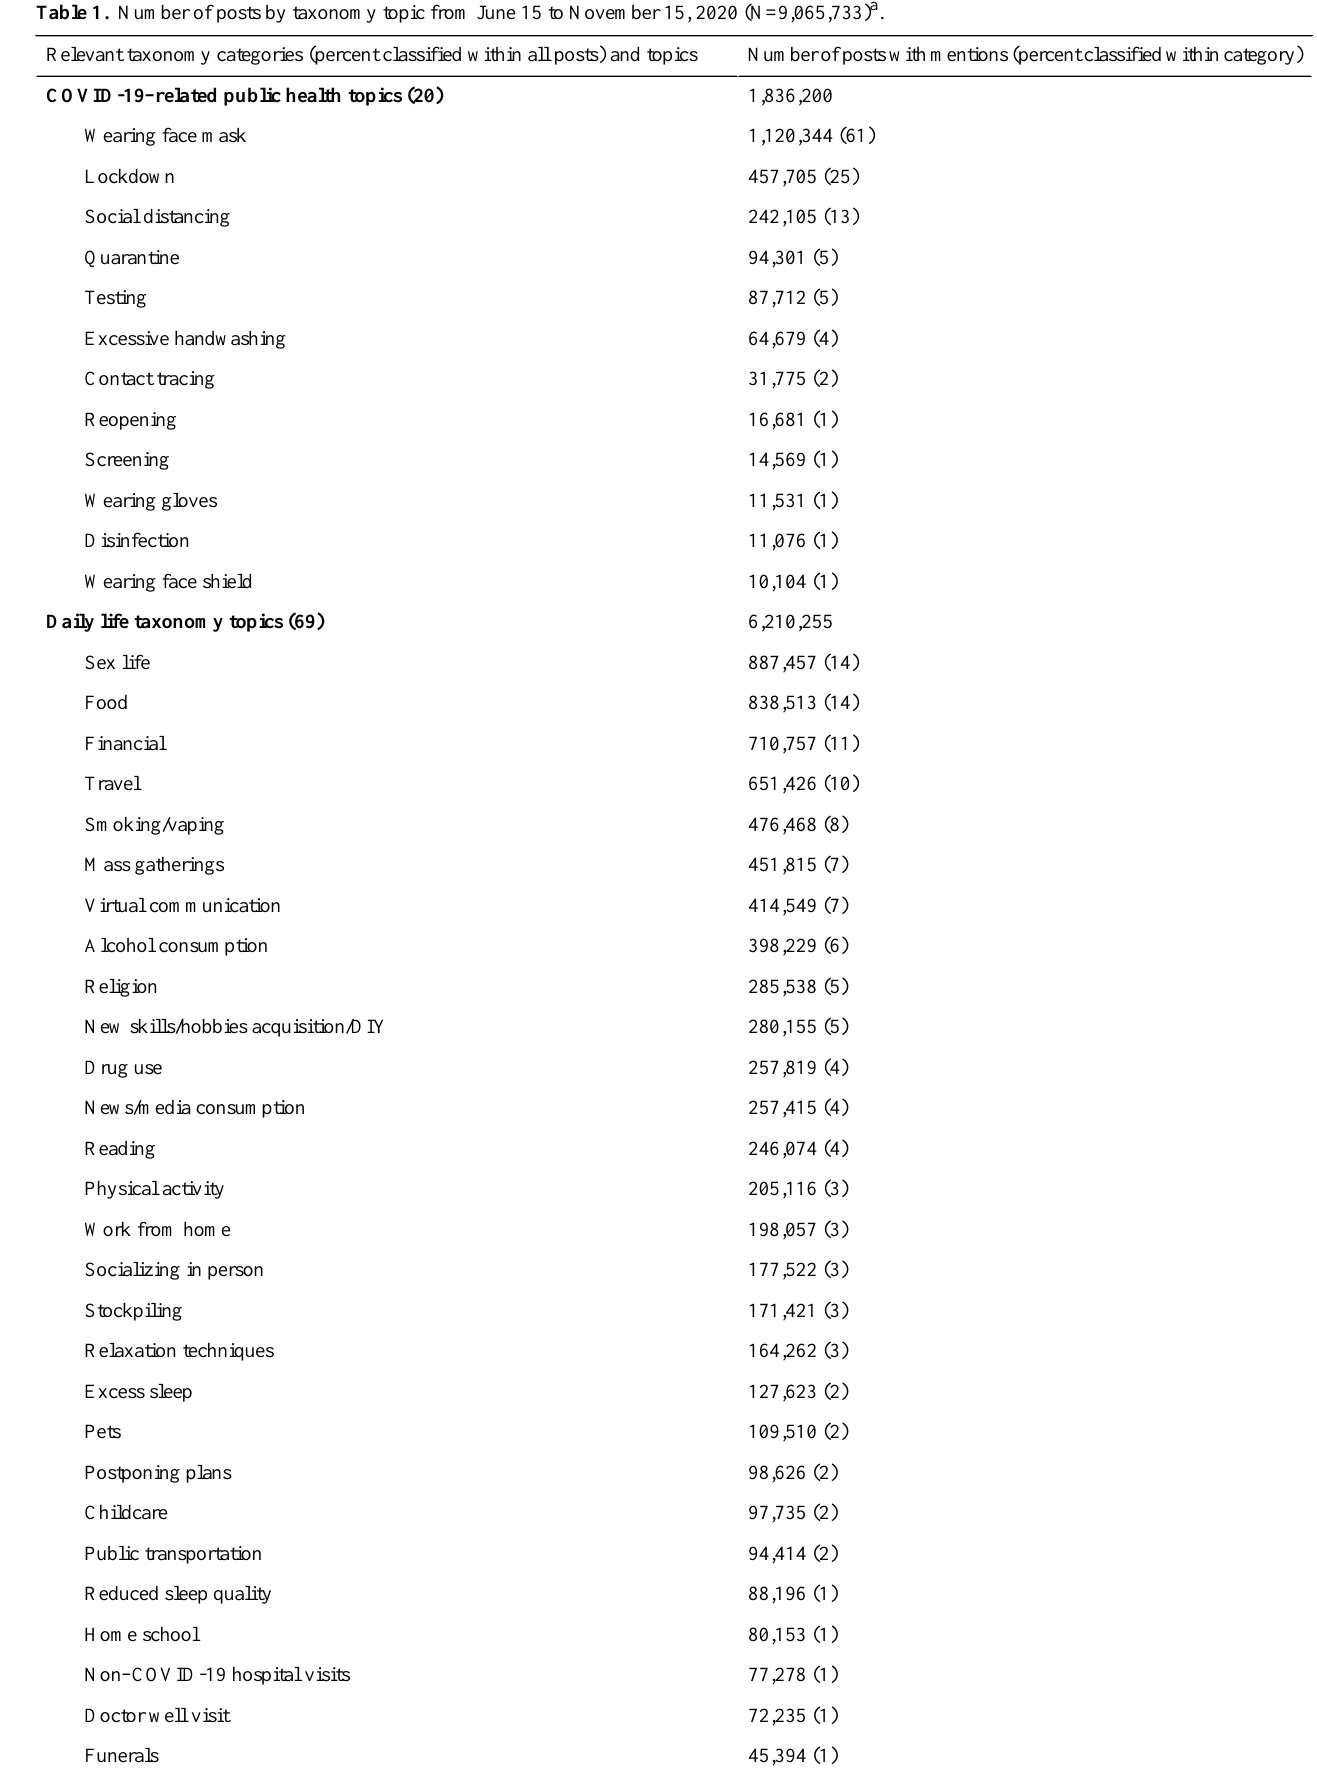
Table 1. Number of posts by taxonomy topic from June 15 to November 15, 2020 (N=9,065,733) a .